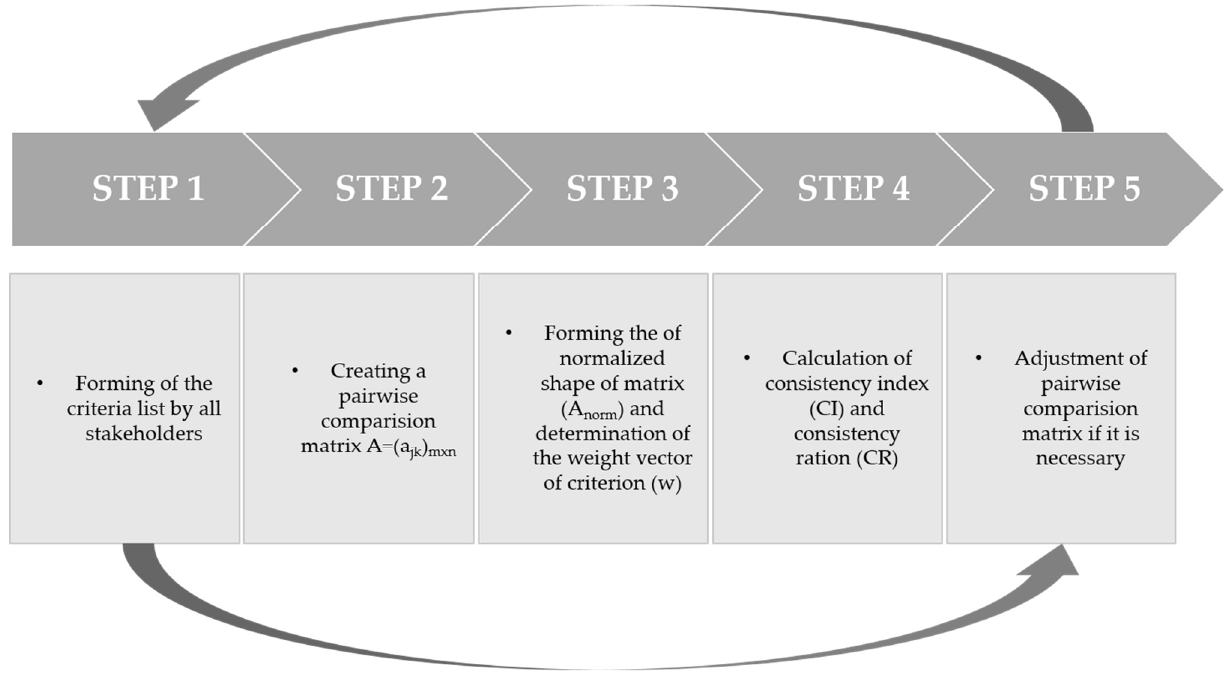
Figure 5. Concept of sub-model for determination of relative criteria weight.